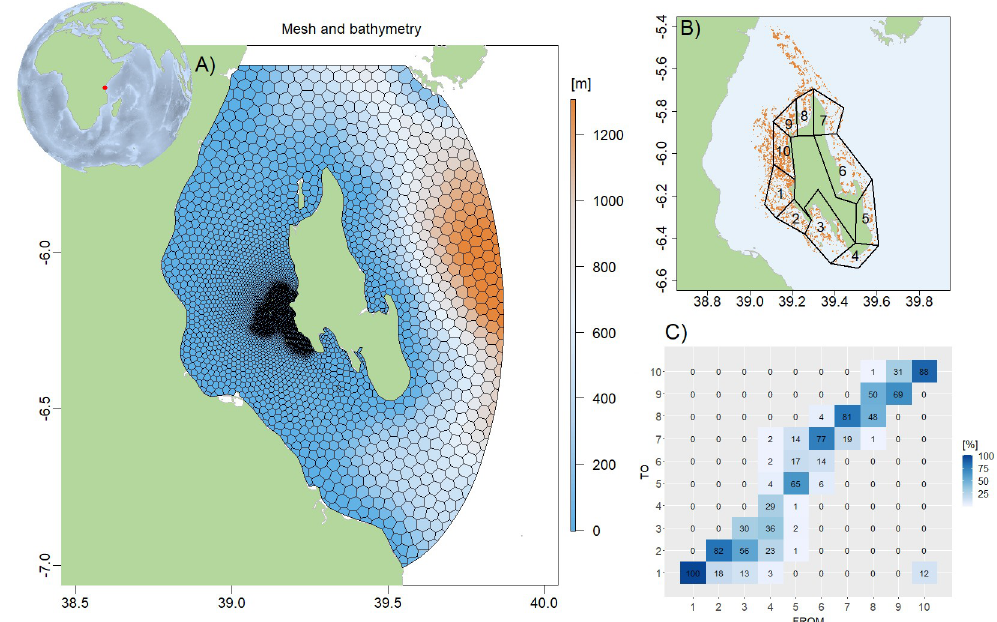
Fig 7. Zanzibar, Tanzania, East Africa. A) Computational mesh and bathymetry. B) Model area showing the agents (orange) and the area division into polygons. C) Downstream connectivity matrix for the 10 polygons in Zanzibar coastal area. The color code indicates the probability of the shoots from each polygon (FROM) to end up in each of the other 10 polygons (TO), with the diagonal elements being the probability of the shoots to stay in the same polygon (self-recruitment).